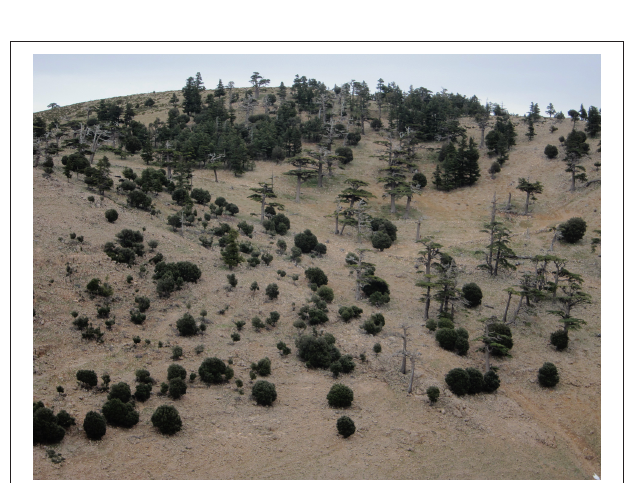
FIGURE 4 | Vegetation cover in the Lake Sidi Ali catchment in 2014. Cedrus atlantica trees showing signs of crown and/or branch dieback as well as dead individuals are common, interspersed with young healthy specimens of Quercus rotundifolia . (Credit: W.